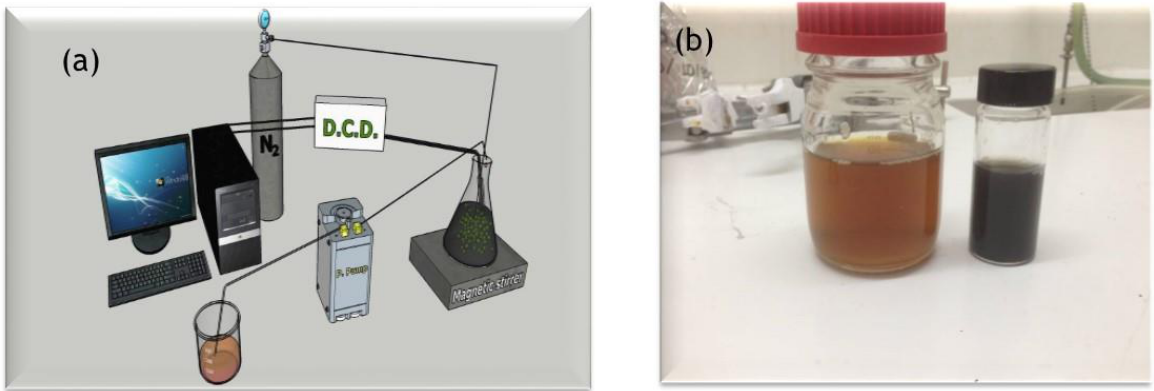
Figure 1. (a) Schematic diagram of the experimental setup; (b) Green Tea extract and its product after its mixing with FeSO 4 ·7H 2